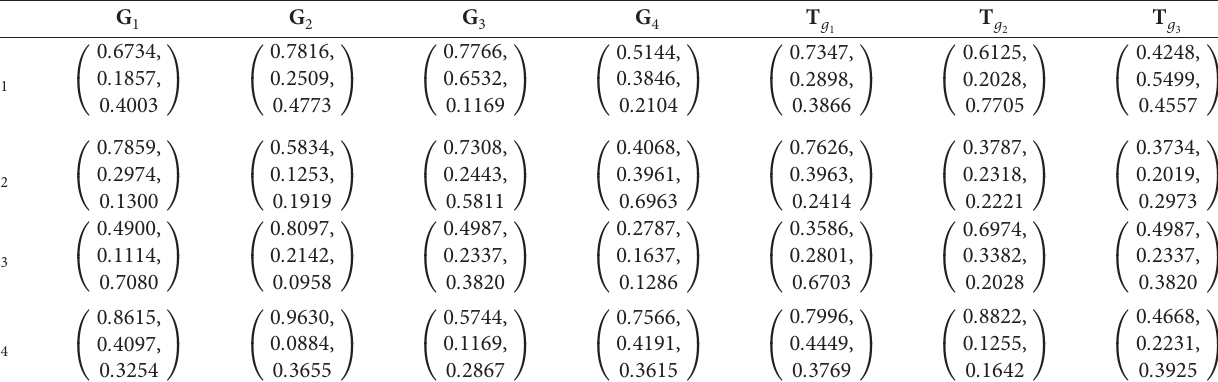
Table 5: Aggregated values by utilizing the GGTSFWG